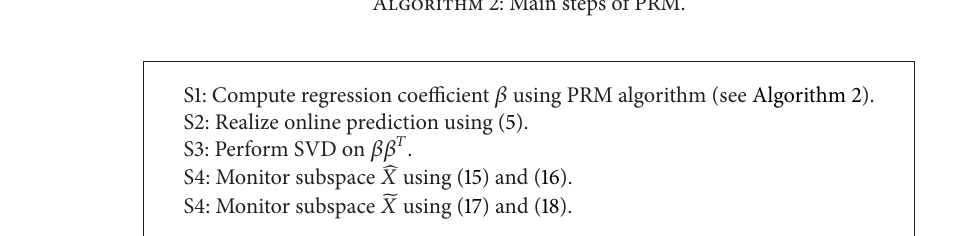
Algorithm 2: Main steps of PRM.